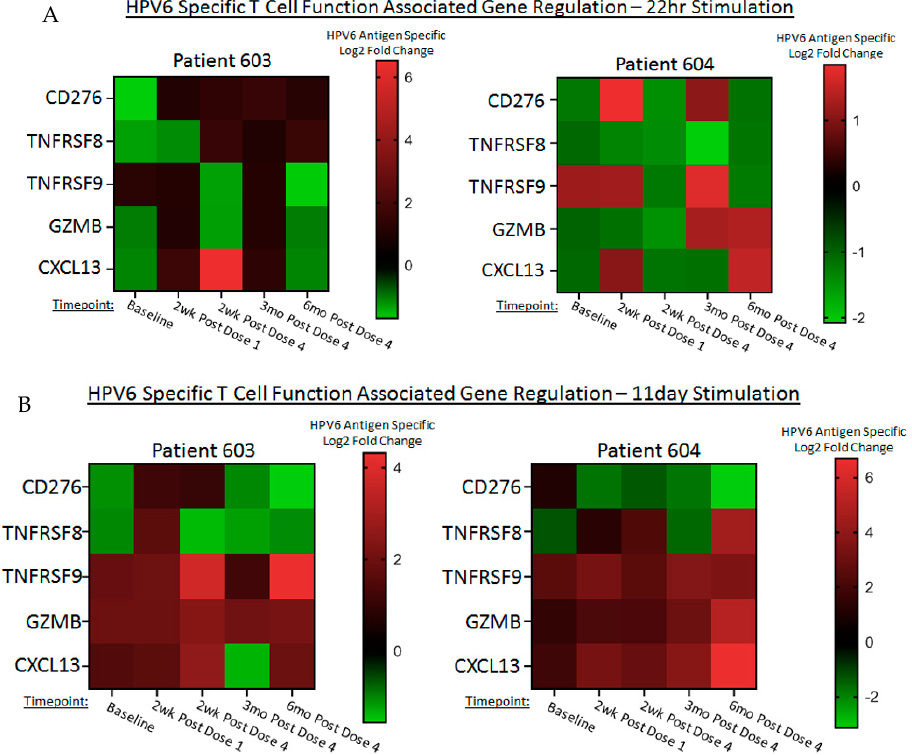
Figure 4. Immune gene transcripts are differentially regulated in an HPV6 specific fashion after treatment with INO-3106. Heat maps showing fold difference of differentially expressed genes in stimulated versus unstimulated cells pre and post vaccination. ( A ) Fold change in gene expression ( ≥ 2-fold) in cells stimulated with peptide pool versus medium alone for 24 hours. ( B ) Fold change in gene expression ( ≥ 2-fold) after 11 days of T cell expansion followed by restimulation of cells with peptide pool versus medium alone for 24 hours. Data are transformed to log 2 fold change, with red indicating upregulation and green indicating downregulation.